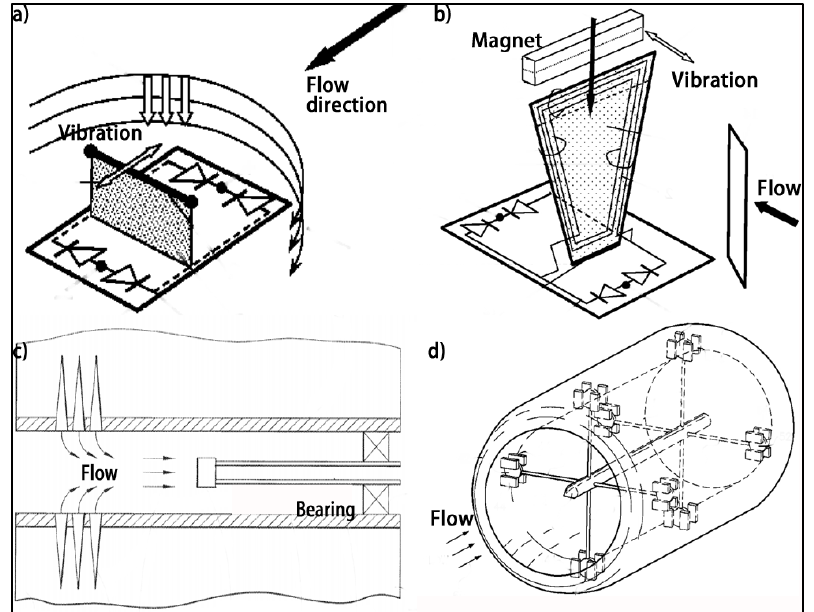
Figure 9. Unidirectional flow-induced energy harvesting examples in patents. ( a ) Square captive device by electromagnetic effect. ( b ) Trapezoid converter by electromagnetic effect. ( c ) Flow energy harvester of artificial environment. ( d ) Fluid EH of artificial pipeline.